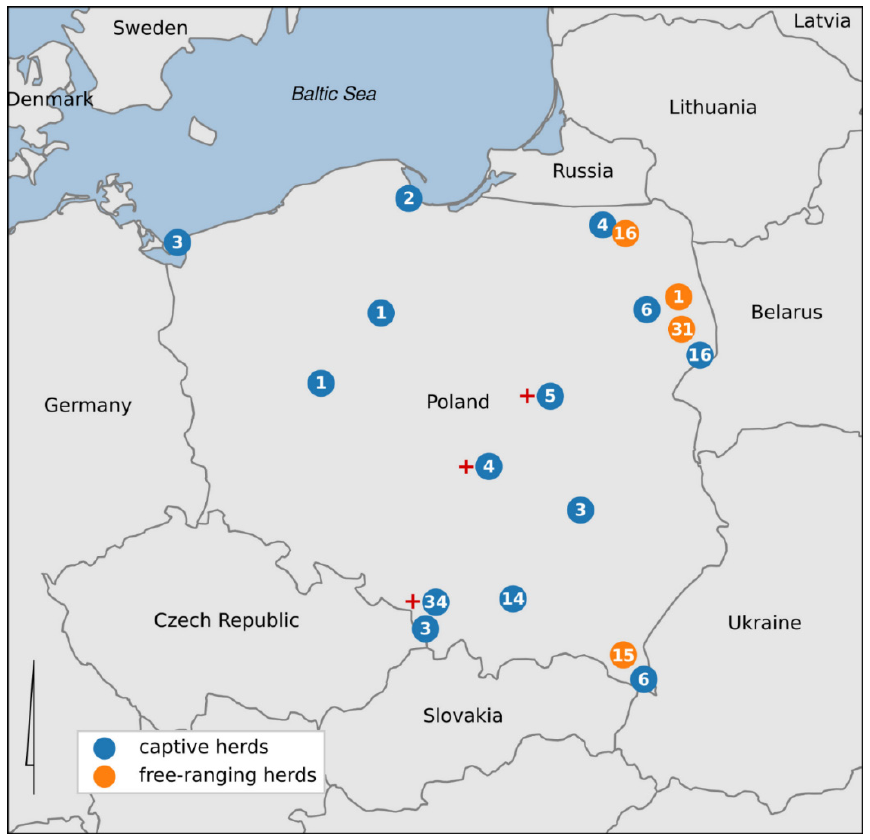
Figure 1. The map of Poland with marked captive and free-ranging European bison herds serologically tested for paratuberculosis (number of tested bison from each localization in a circle). The plus sign indicates populations where the individual with a positive test for M. avium spp. paratuberculosis antibodies were found. Table 1. The numerical ratios of the studied European bison in terms of age, sex, and the type of herd.